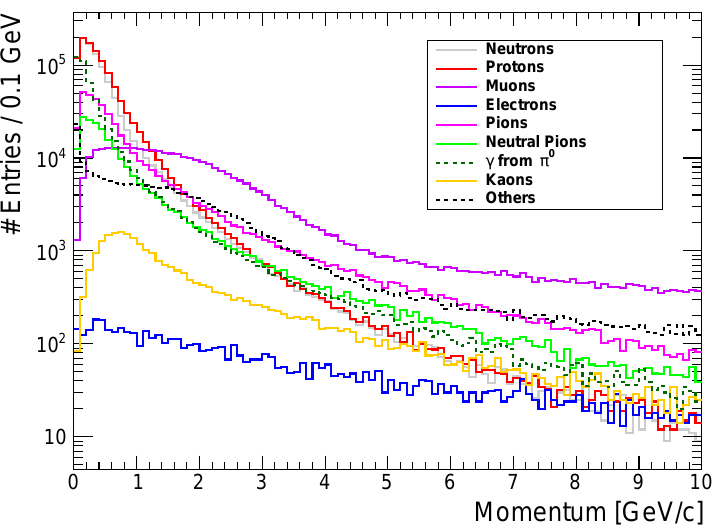
Figure 75. GENIE prediction of momentum spectra for particles resulting from neutrino interactions in ND-GAr, shown in log scale on the vertical